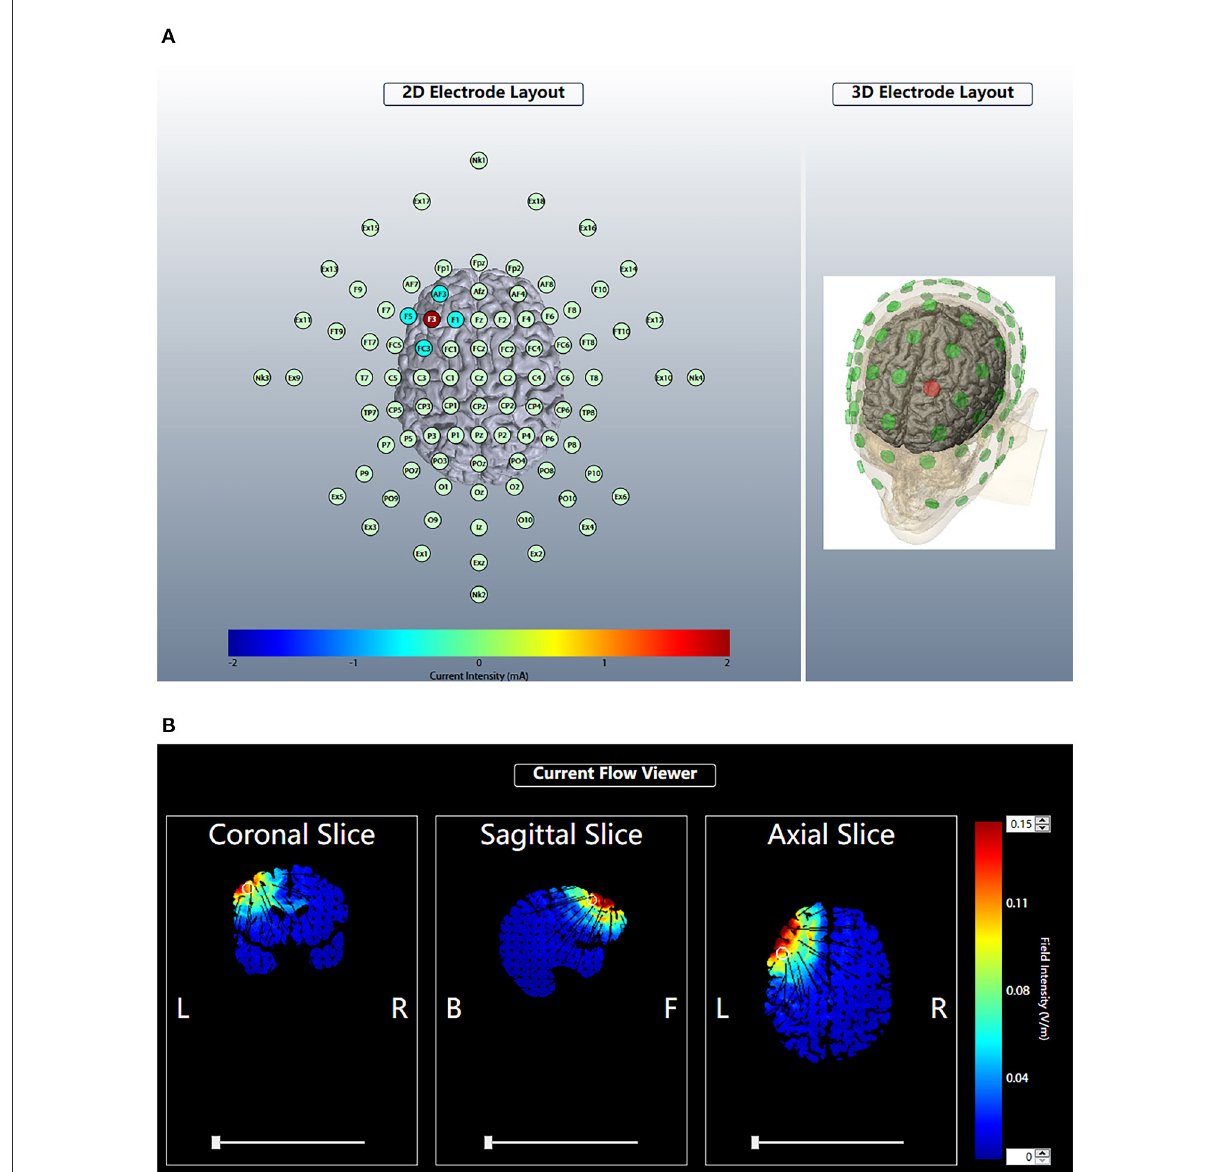
FIGURE2 Brain modulation during HD-tDCS using the 4 × 1 ring configuration. According to the International 10-20 system, the anodal electrode was placed at F3. The four cathodal electrodes were placed on AF3, F5, FC3 and F1. The current intensity was 2mA (A) . For each plane, we estimated the theoretical current flow in terms of the modeled electric field normal component (nE, V/m) at the cortex of the HD-tDCS electrode array by Soterix HD-Explore. Blue indicates zero electric field (0 V/m), while red indicates peak magnitude (0.15 V/m) (B) .